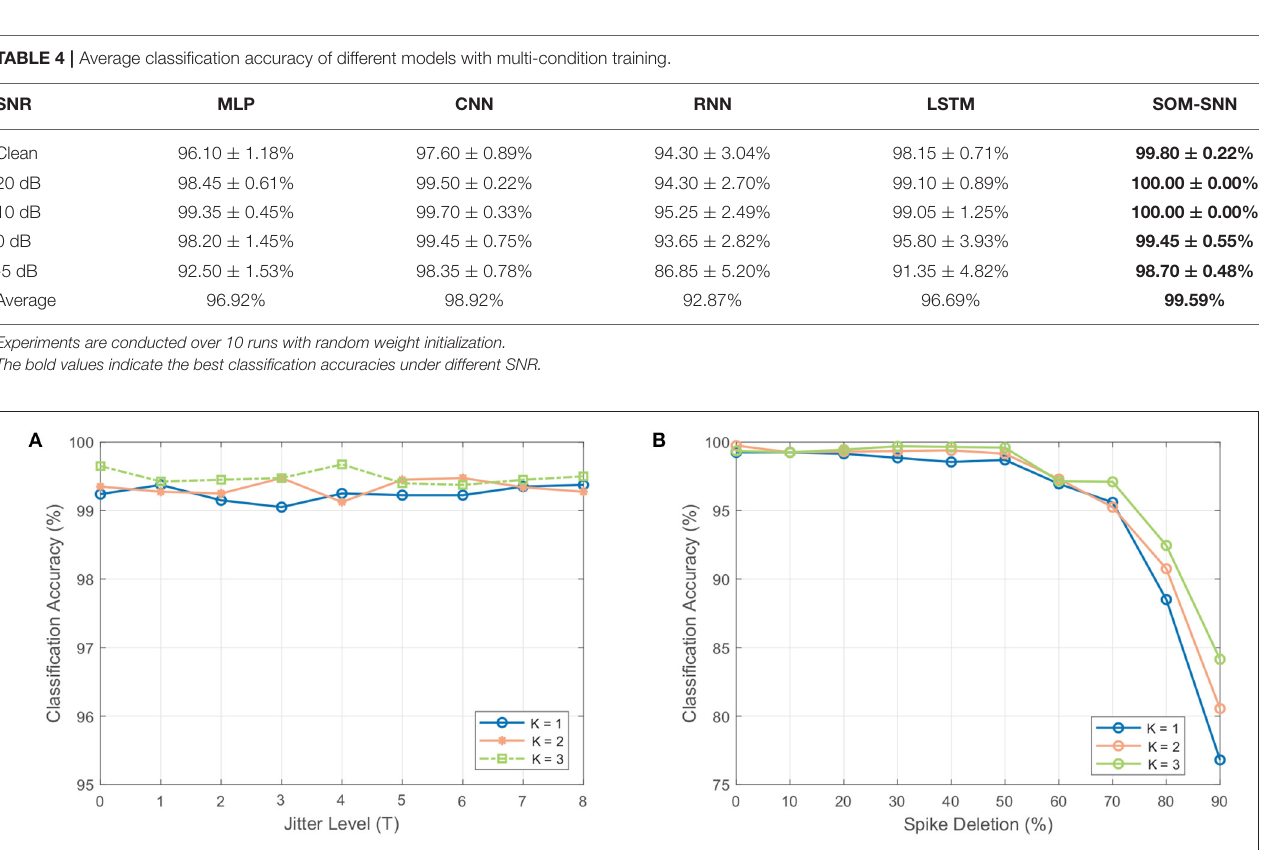
FIGURE 9 | The effect of spike jittering and spike deletion on the classification accuracy. (A) Classification accuracy as a result of spike jitter added at the input to the SNN classifier. The amount of jitter is added as a fraction of the spike generation period T (i.e., 50 ms used for the RWCP dataset). The classifier is robust to spike jitter, maintaining a high accuracy with different amount of jitter. (B) Classification accuracy as a result of spike deletion at the input to the SNN classifier. The accuracy of the classifier remains stable for spike deletion ratio below 60% and decays with increased spike